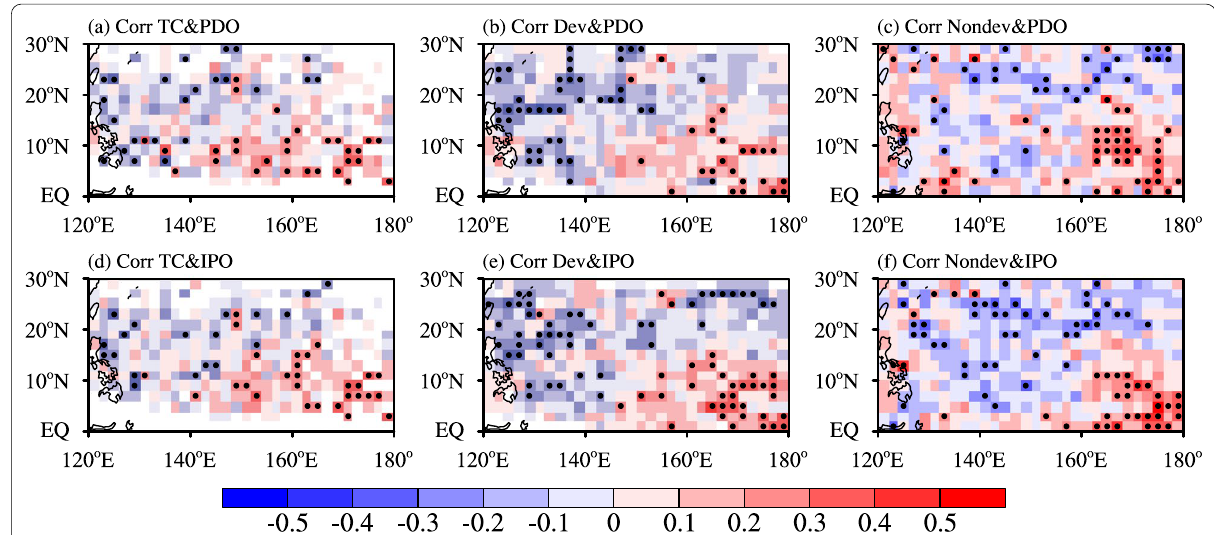
Fig. 7 The spatial distribution of the correlation coefficients between the PDO index and a TC genesis, b developing disturbances track density, and c nondeveloping disturbances track density in each 2°